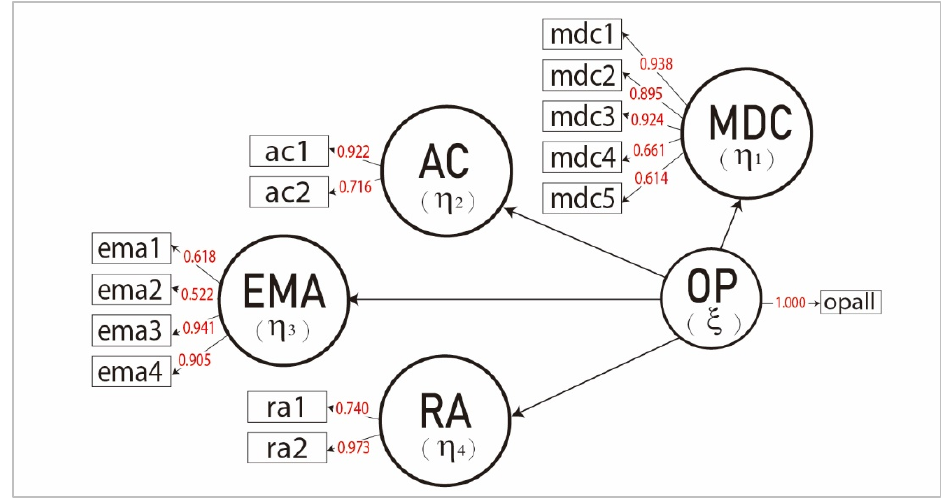
Figure 4. Indicator loadings. Source: results obtained in this study using SmartPLS 4 software. Table 2. Construct reliability and validity.